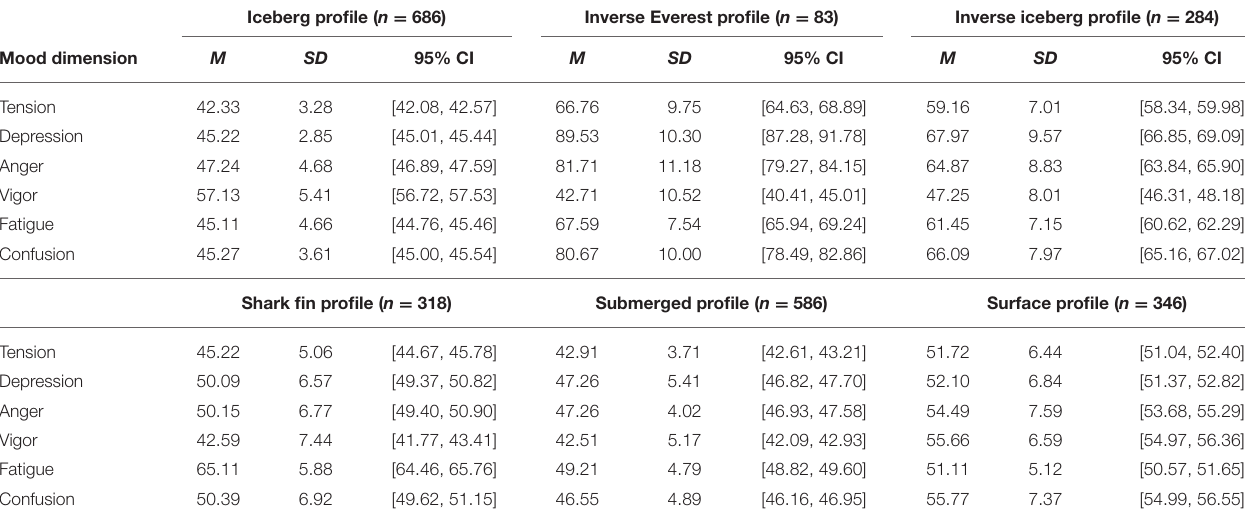
TABLE 9 | Descriptive statistics of the 6-cluster solution in Sample B ( n = 2,303). Iceberg profile ( n = 686) Inverse Everest profile ( n = 83) Inverse iceberg profile ( n = 284)